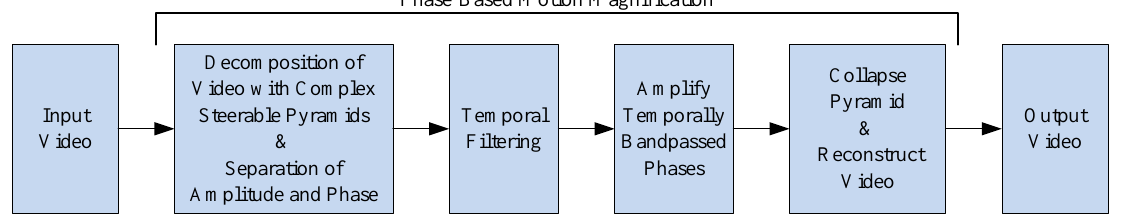
Figure 2. Workflow process of the phase-based motion magnification (PBMM) algorithm to amplify motion in a video within a defined frequency